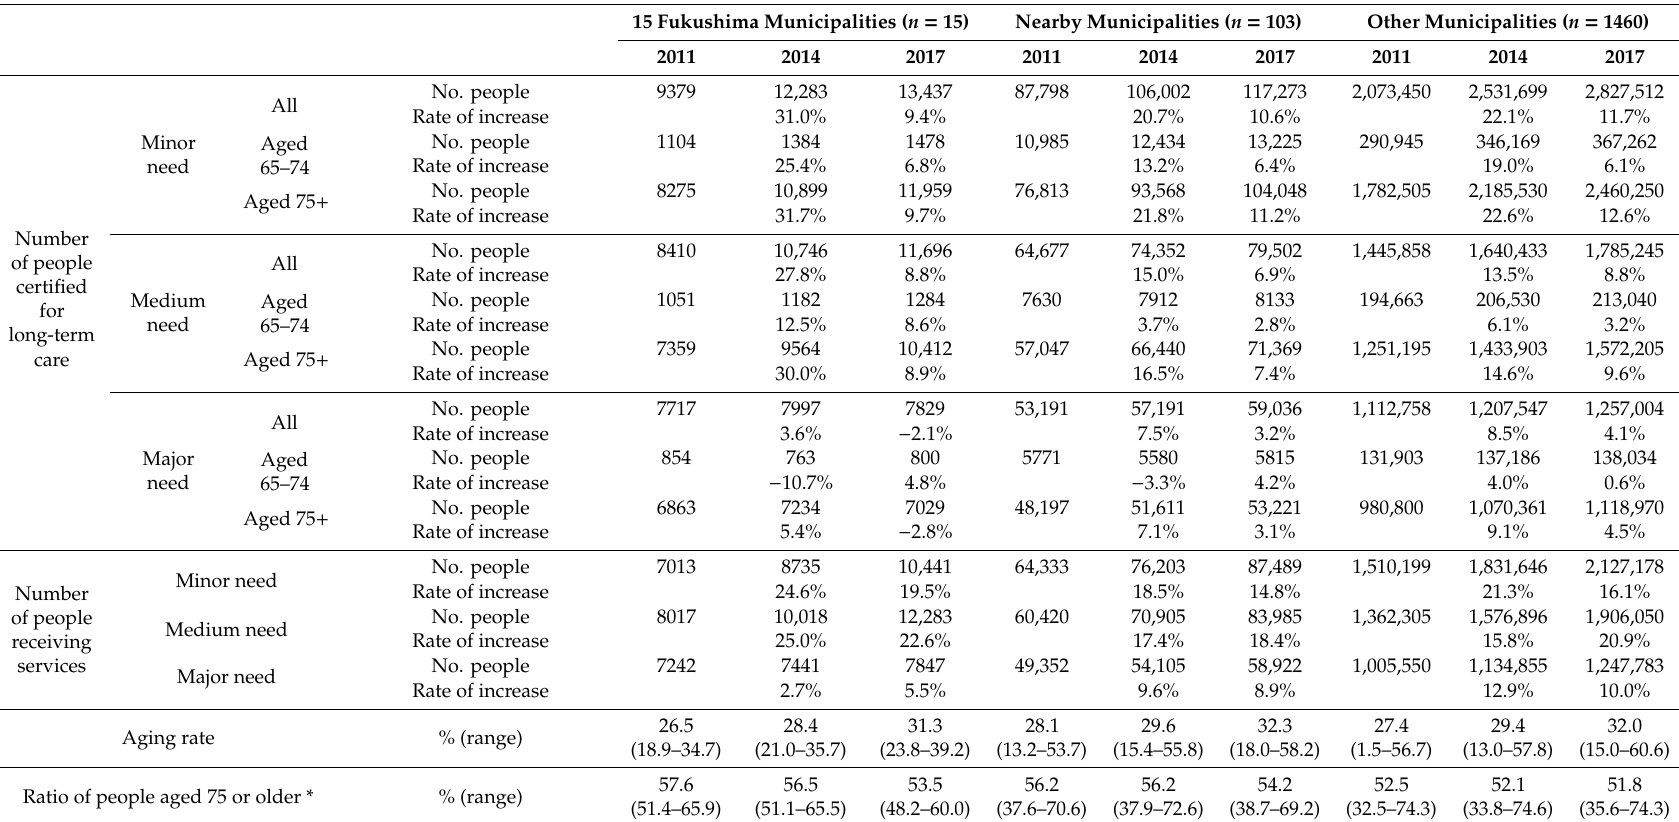
Table 1. Number of people eligible for long-term care and number of people receiving services. 15 Fukushima Municipalities ( n =